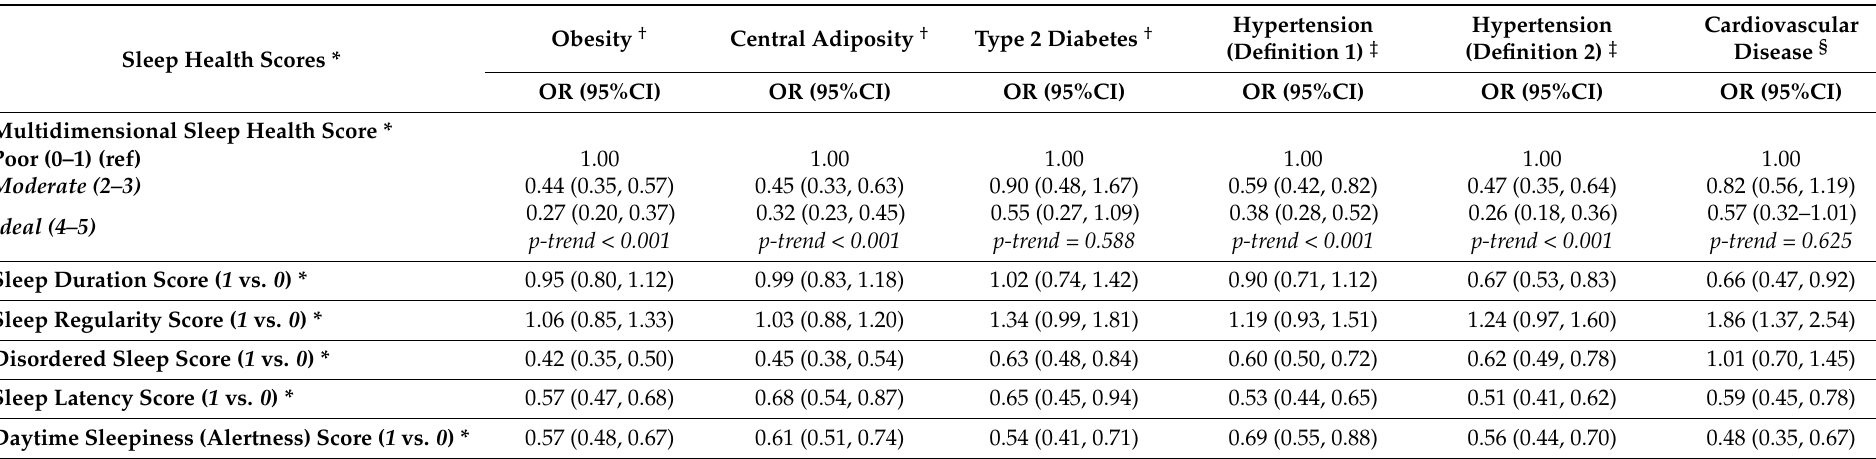
Table 3. Multivariable-Adjusted Logistic Regression Models for Associations of Multidimensional Sleep Health with Odds of Cardiovascular Disease and Cardiometabolic Outcomes (n = 4555) ||